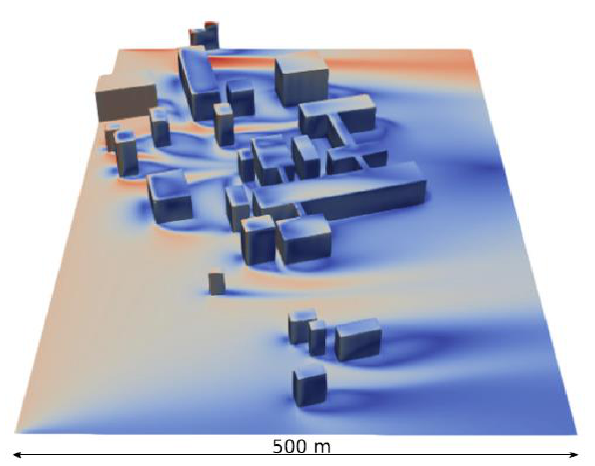
Figure 2. Building scale flow field over a set of buildings simulated using CFD software [10].